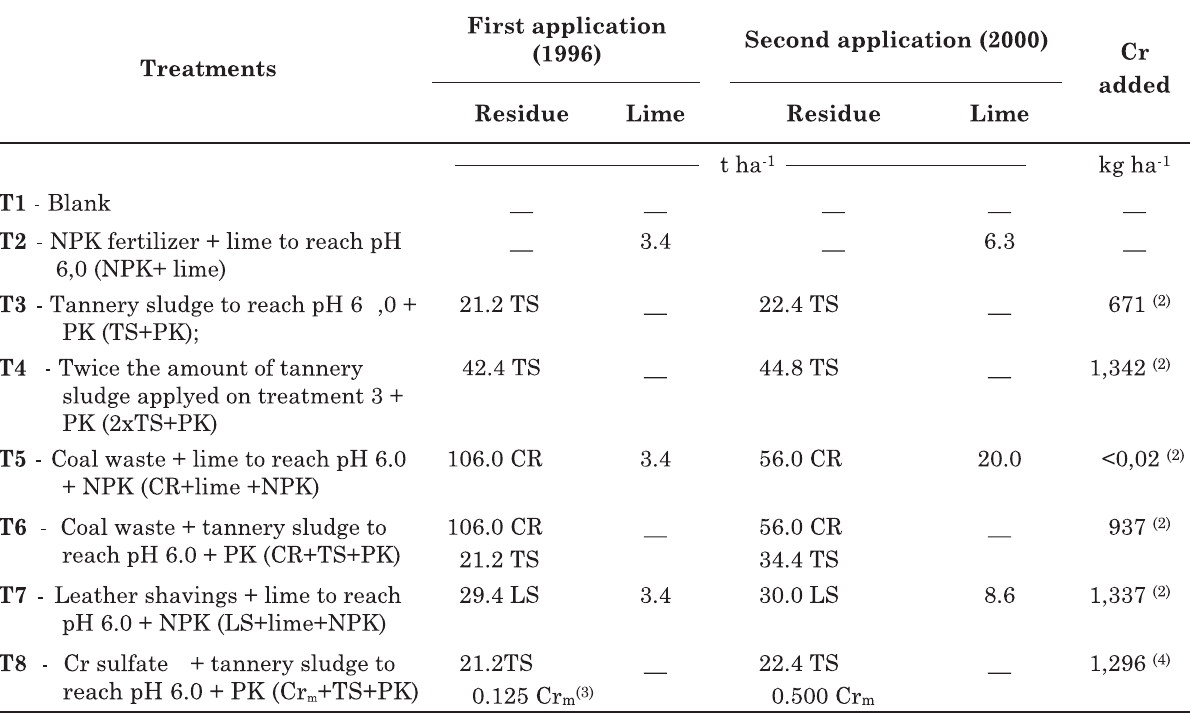
Table 2. Treatments, residue amounts applied and chromium added